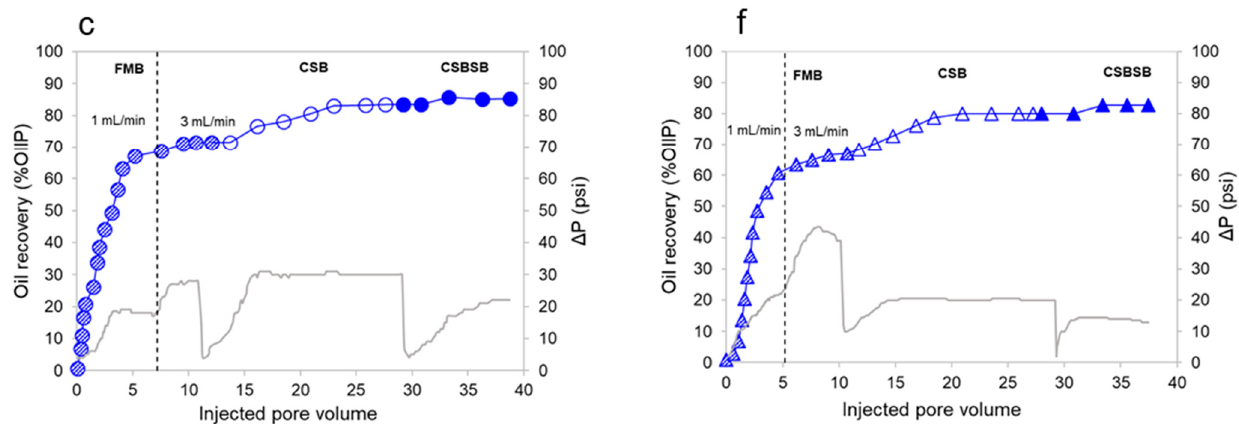
Figure 5. Oil recovery during secondary injection of FMB, tertiary injection of CSB and quaternary injection of CSBSB. Red patterned, hollow and filled circles ( a , b ) correspond to the applications of FMB, CSB and GreenZyme (CSBSB-G) in secondary, tertiary and quaternary flooding respectively carried out at 70 ◦ C on rock sample C06 with initial water saturation of S wi = 0.41, while blue circles ( a , c ) correspond to the experiments at 23 ◦ C on rock sample C03 with S wi = 0.44. Red patterned, hollow and filled triangles ( d , e ) correspond to the applications of FMB, CSB and rhamnolipid (CSBSB-R) in secondary, tertiary and quaternary flooding respectively carried out at 70 ◦ C on sample C22 at S wi = 0.44, while blue triangles ( d , f ) represent the results obtained with C15 at 23 ◦ C and with S wi = 0.44. Grey curves show the measured pressure difference across the samples and vertical dashed lines indicate a transition from the injection rate of 1 mL/min to 3 mL/min.